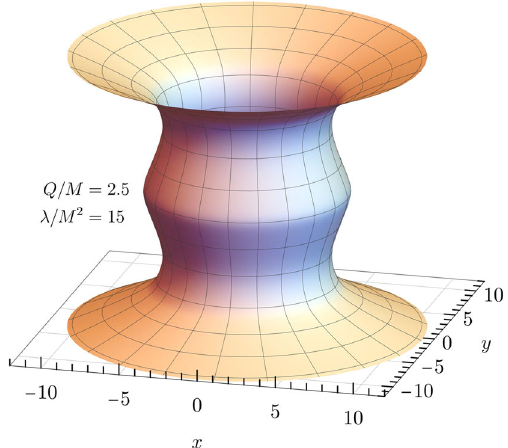
Fig. 24 Same as Fig. 23 for Q / M = 2 . 5 and λ/ M 2 = 15 for coupling function (iii)